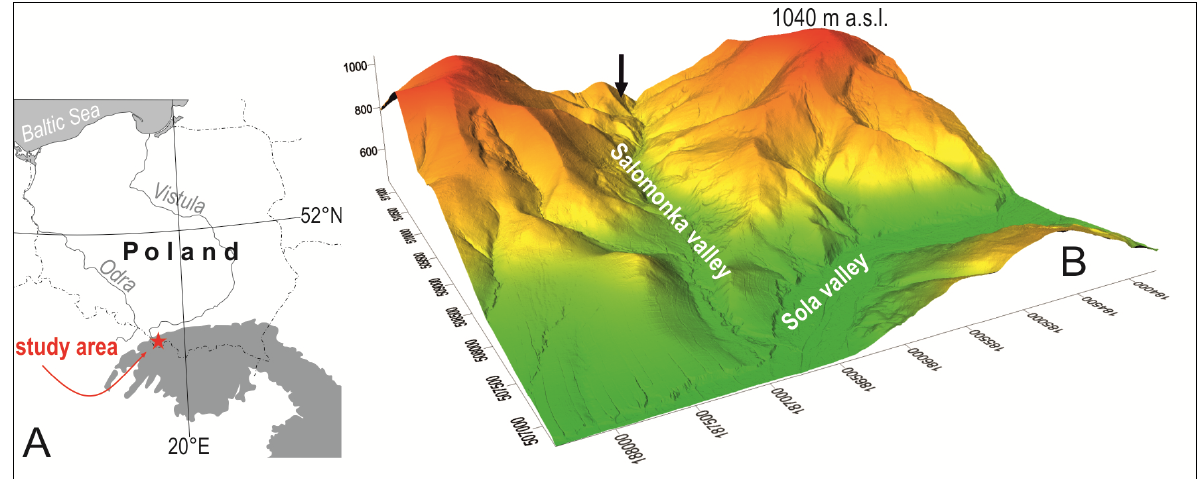
Fig. 2. Location of the study area in the Western Carpathians (A), in the Beskid Żywiecki Mountains and on the slopes of Sucha Mountain (B). An arrow marks the location of the reference